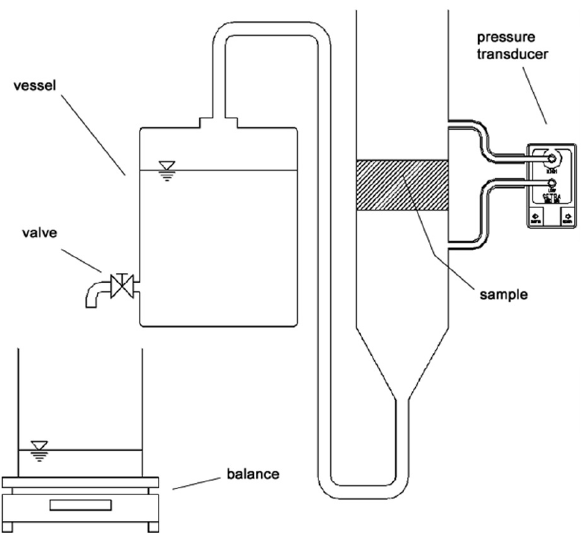
Figure 1: Flow resistance measurement equipment Figure 2: Vertical standing wave